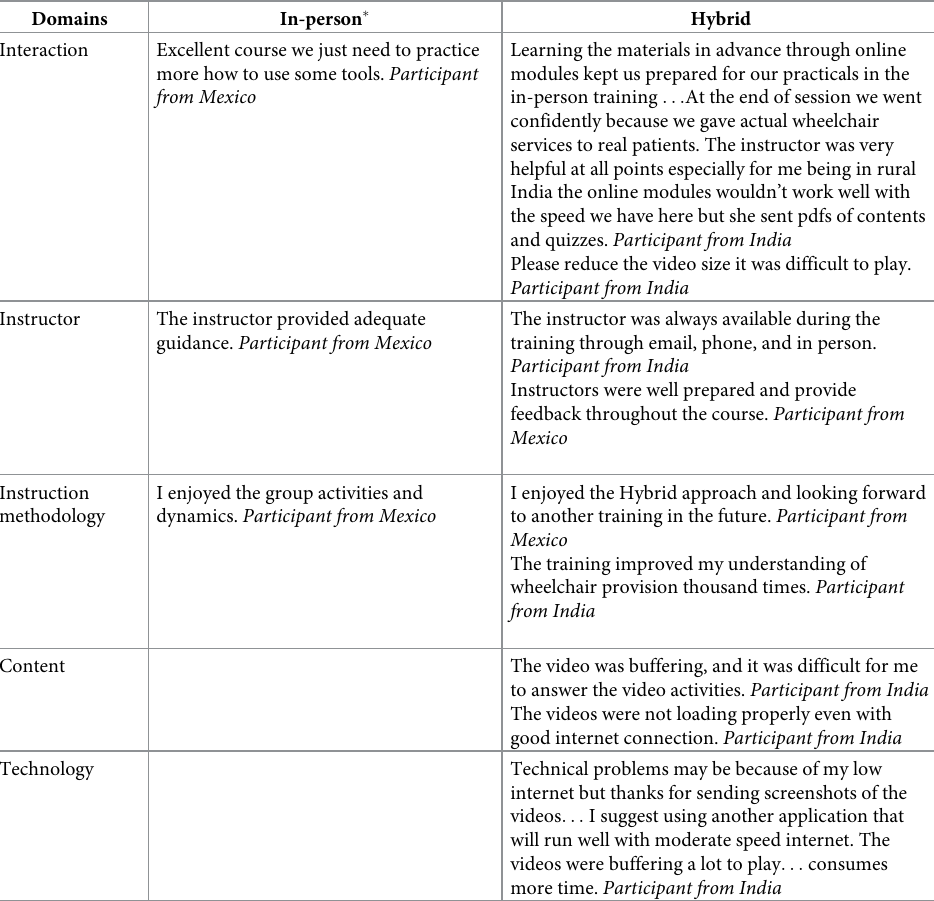
Table 9. Some participants’ comments from the In-person and Hybrid